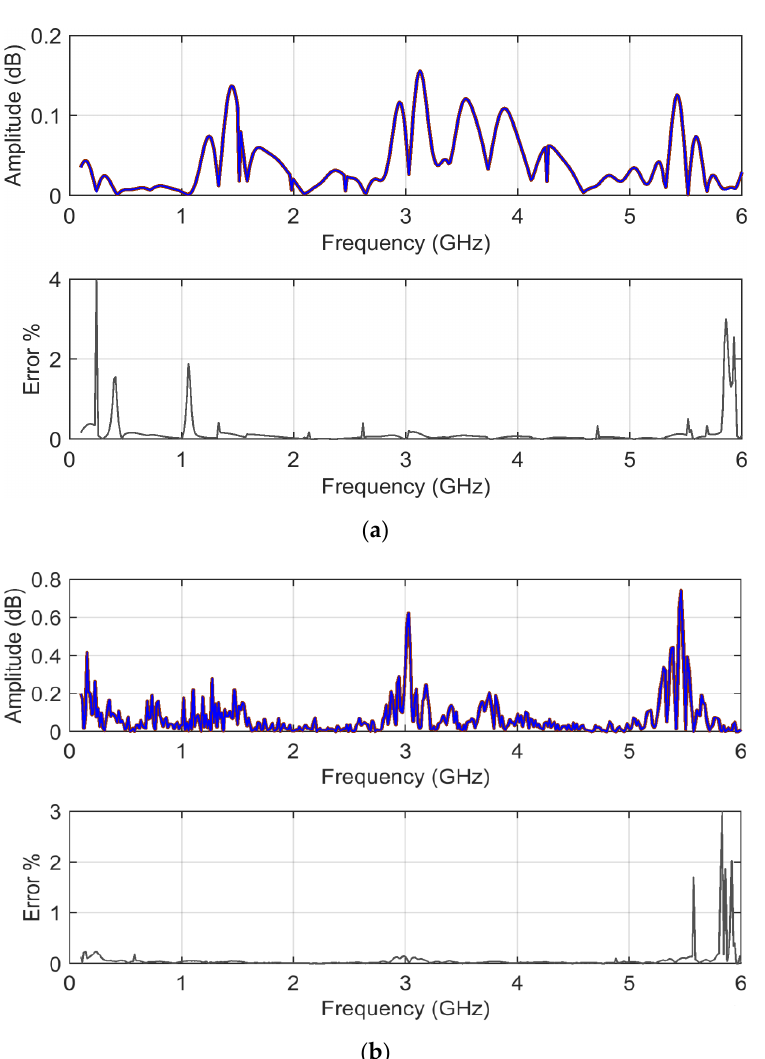
Figure 12. S 11 input data in logarithmic scale: ( a ) ADM i and ( b ) FDM i plots as provided by analytical FSV calculation (blue) and mean of MCM output (brown); blue and brown curves are overlapped with underlying brown curve visible at the edges of the blue one.